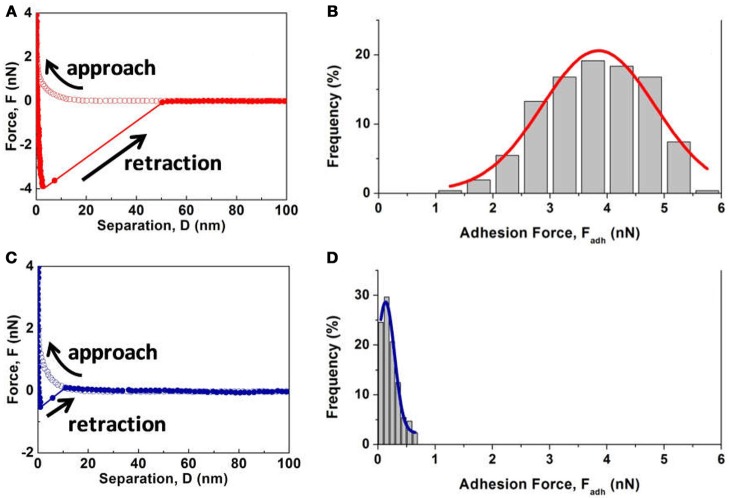
(A,C) Typical force-separation curves and (B,D) histograms of measured adhesion Fadh between CMC functionalized AFM tip and (A,B) MoS2 basal plane or (C,D) edge plane in 1 mM NaCl at pH 9.